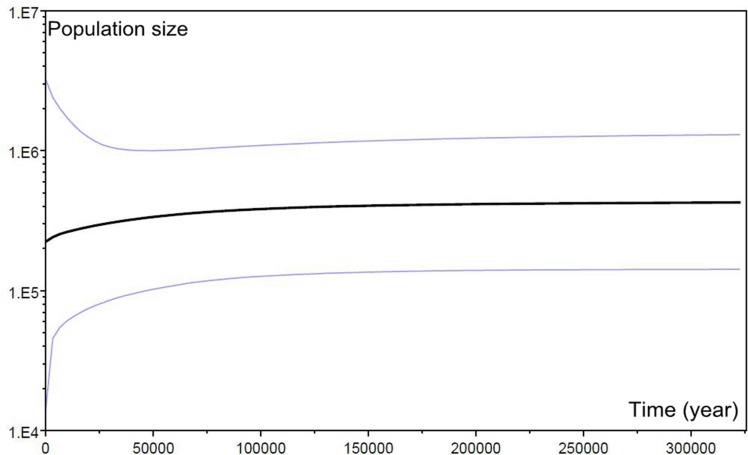
Bayesian skyline plot based on cpDNA for the effective population size fluctuation throughout time.black line, median estimation; area between gray lines, 95% confidence interval.